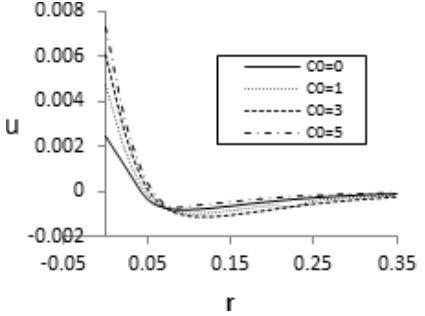
Figure 4: Distribution of displacement with the radius via RPL ℜ = 2